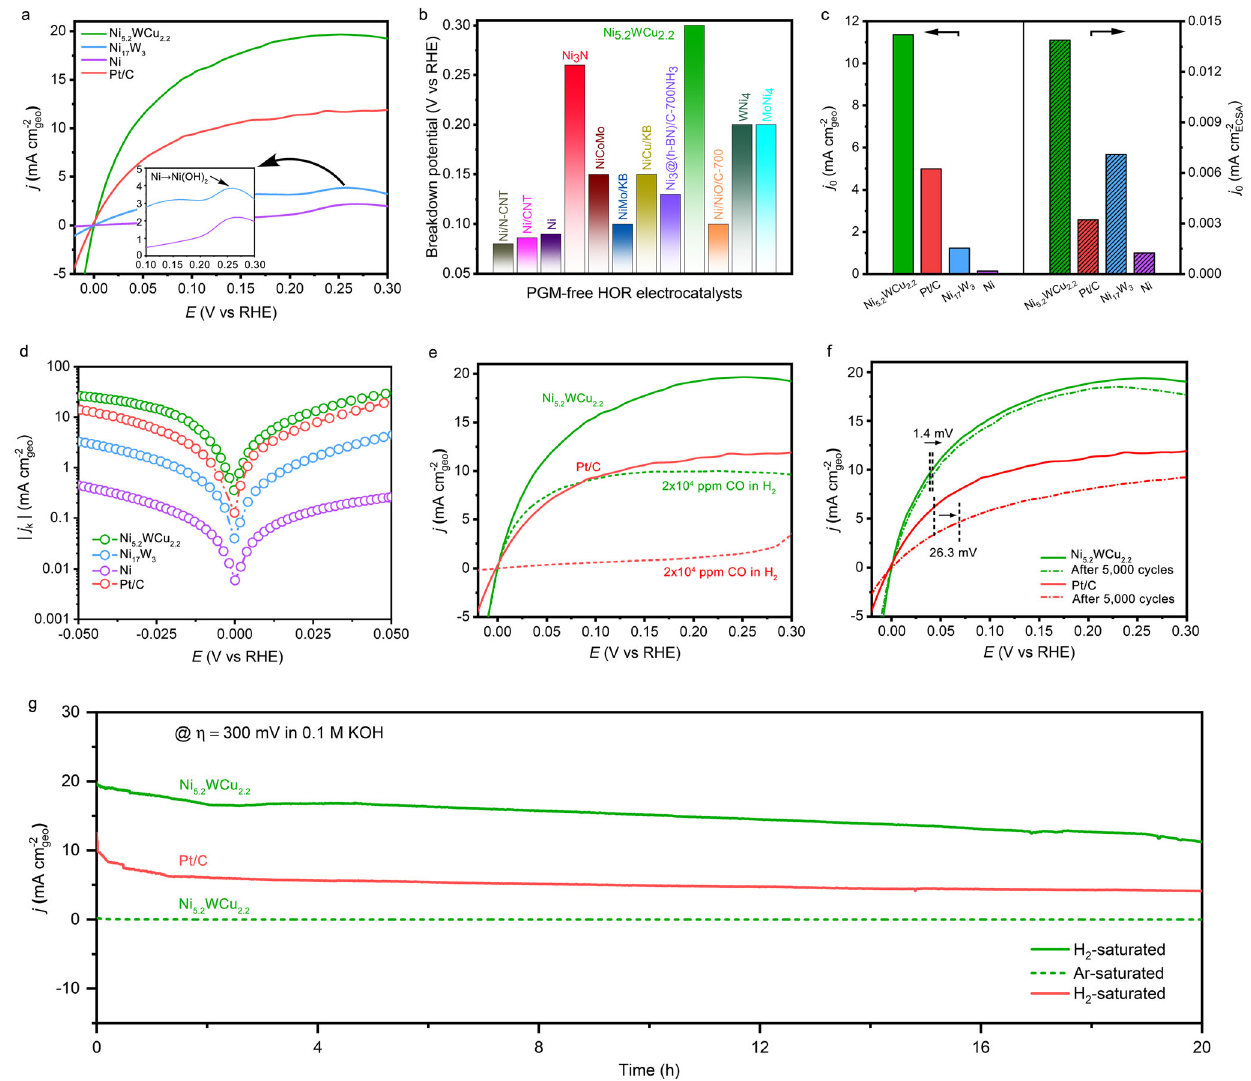
Fig. 3 Electrocatalytic HOR performances. a Polarization curves for the HOR on Ni 5.2 WCu 2.2 , Ni 17 W 3 , Ni, and commercial Pt/C catalyst measured in H 2 - saturated 0.1 M KOH. Scan rate: 1 mV s − 1 . Inset shows HOR curves at high anode potentials, showing the surface oxidation of Ni 17 W 3 and Ni catalysts. b Comparison of breakdown potential of Ni 5.2 WCu 2.2 with various PGM-free HOR catalysts reported previously. Breakdown potential means HOR stops at this potential. c Comparison of exchange current density ( j 0 ) of various studied catalysts normalized by geometric areas (unpatterned) and ECSA (patterned), respectively. d HOR/HER Tafel plots of the kinetic current density on Ni 5.2 WCu 2.2 , Ni 17 W 3 , Ni, and Pt/C in H 2 -saturated 0.1M KOH. e HOR polarization curves for Ni 5.2 WCu 2.2 alloy and Pt/C catalyst in H 2 -saturated 0.1M KOH with (dashed lines) and without (solid lines) the presence of 20,000 ppm CO. f HOR polarization curves for Ni 5.2 WCu 2.2 alloy and Pt/C catalyst before (solid lines) and after (dashed lines) accelerated durability test, respectively. The durability test was performed at room temperature in H 2 -saturated 0.1M KOH with the cyclic potential sweeping between − 0.2 V to 0.2 V at a sweep rate of 200 mV s − 1 . g Chronoamperometry ( j - t) responses recorded on Ni 5.2 WCu 2.2 alloy and Pt/C catalyst at a 300 mV overpotential in H 2 -saturated 0.1 M KOH at room temperature. Identical measurement on Ni 5.2 WCu 2.2 alloy in Ar-saturated 0.1M KOH was also carried out for